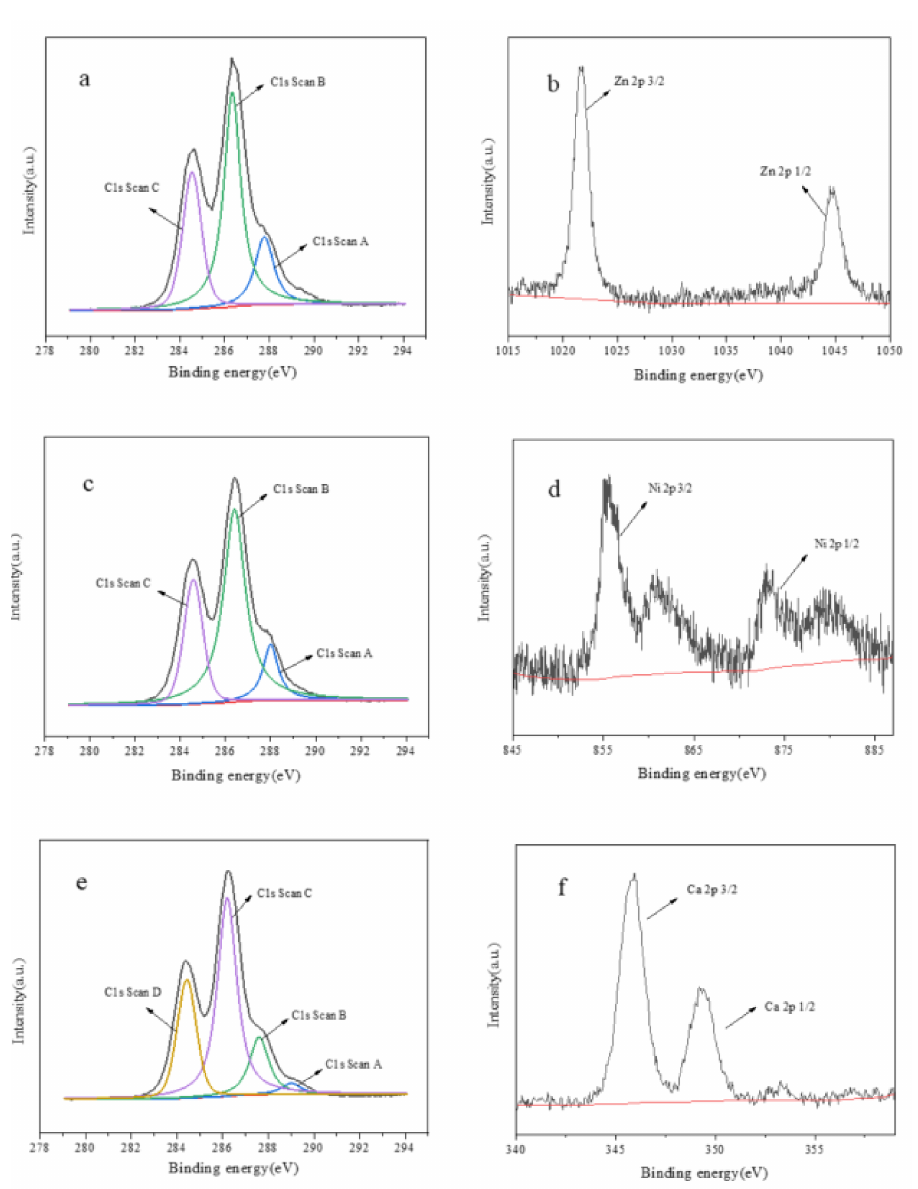
Figure 2. XPS spectra of β -CD-Zn ( a , b ), β -CD-Ni ( c , d ) and β -CD-Ca ( e , f ). The FT-IR spectra of β -CD, β -CD-Zn, β -CD-Ni and β -CD-Ca were shown in Figure 1a. The absorption peak of β -CD and β -CD-M at 3450 cm − 1 was attributed to the stretching